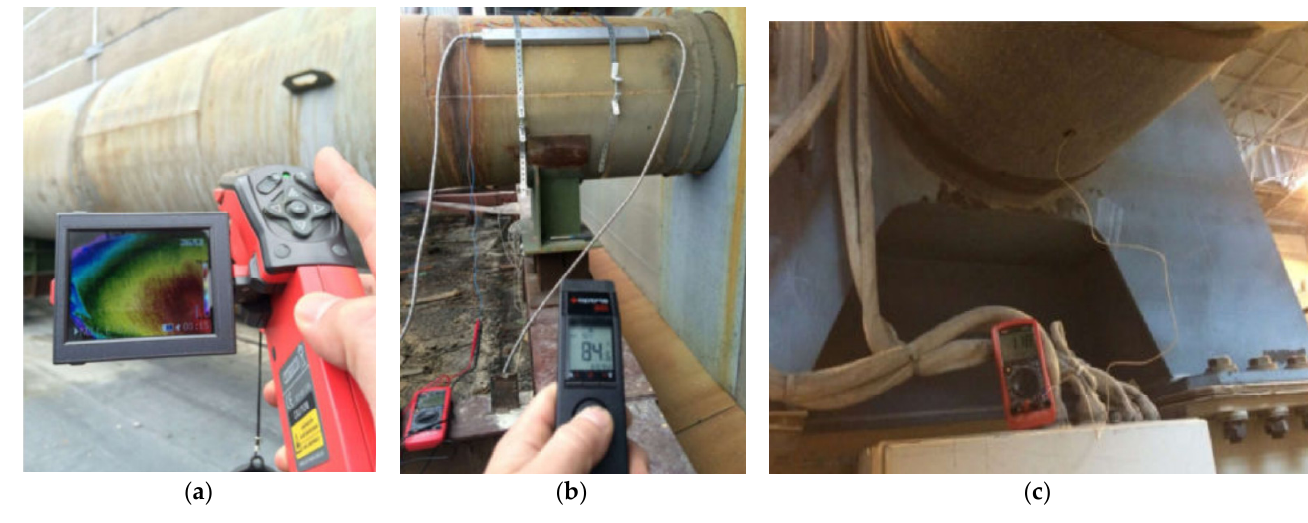
Figure 15. Measurement of the indicators of the temperature values of the walls of the gas ducts with the measuring tools: ( a ) UNI-X thermal imager; ( b ) digital pyrometer Optris MS Plus; ( c ) UNI-X digital multimeter.